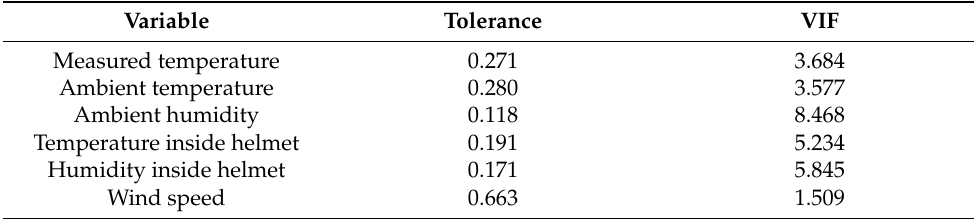
Table 1. Results of covariance test for the influencing factors of infrared temperature measurement of smart